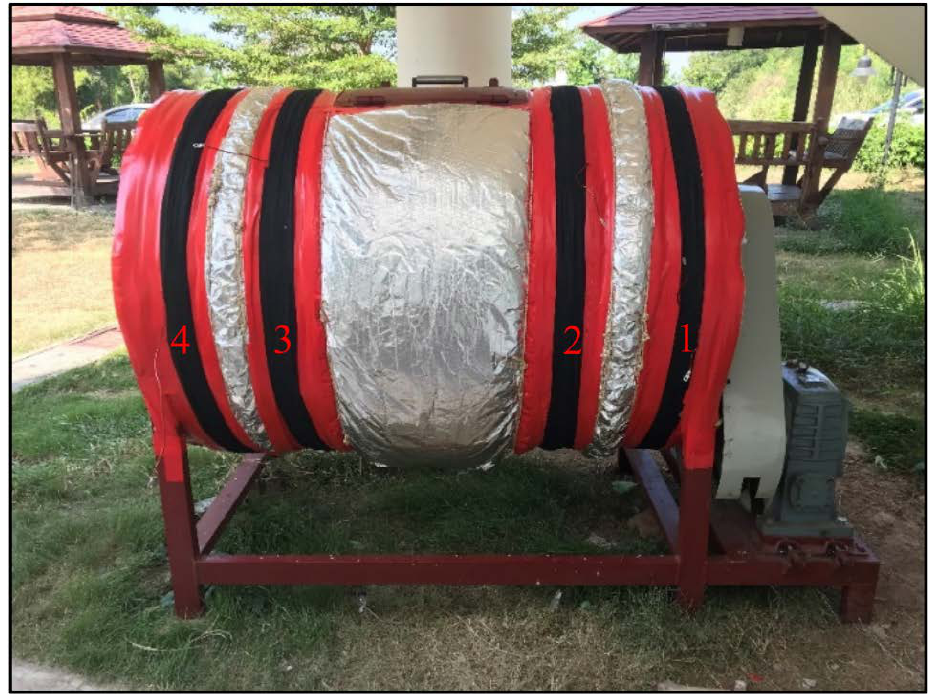
Figure 11. Four sets of wire-wrapped heating bins ready to be used for heating and decomposing organic waste.